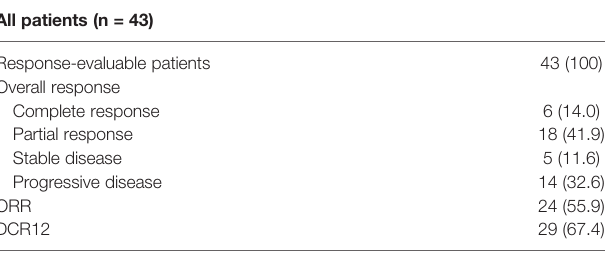
TABLE 3 | Clinical therapeutic evaluation for study patients.